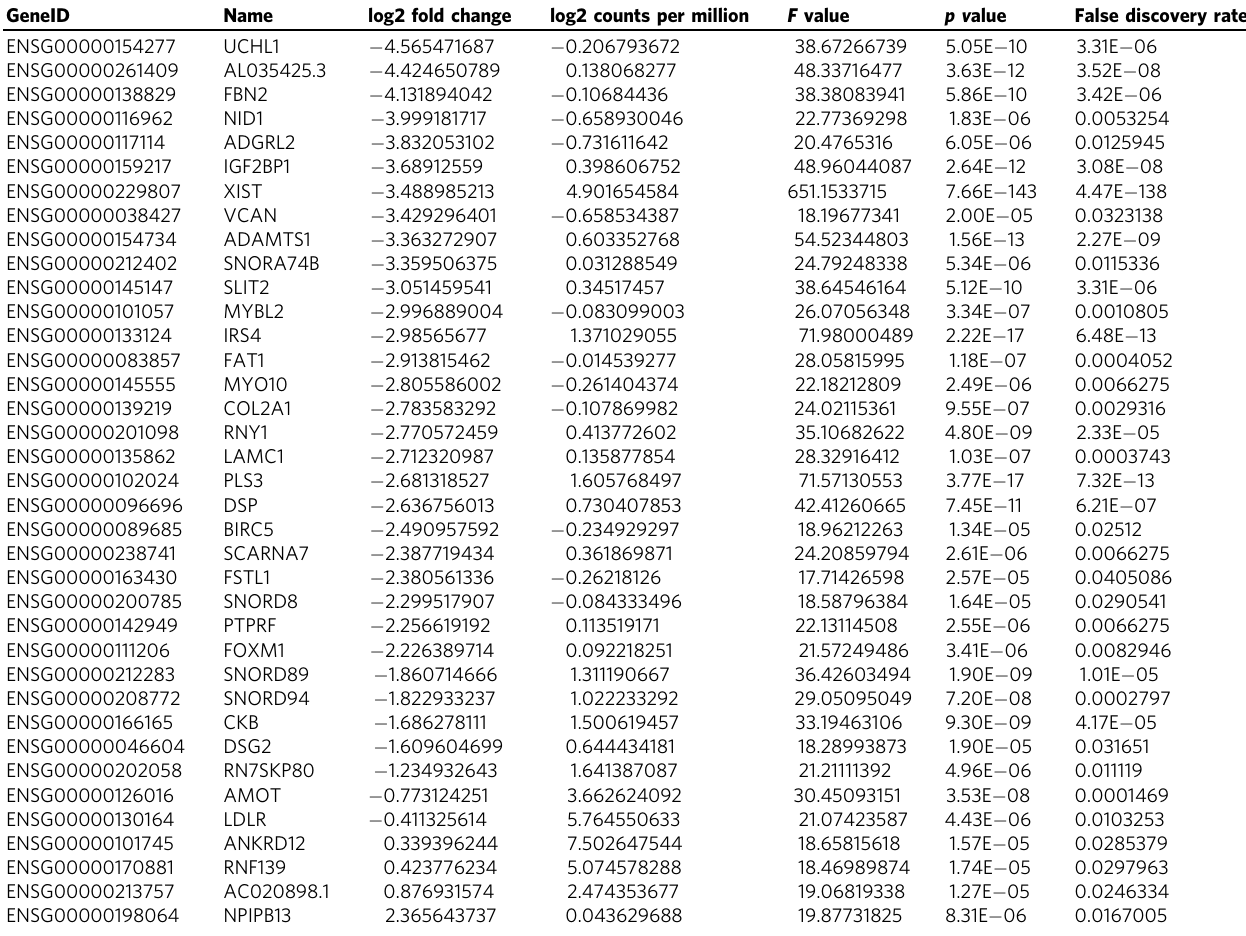
Table 2 EdgeR report of differentially expressed genes 18 h post-treatment with 1 µ M FH-1321.